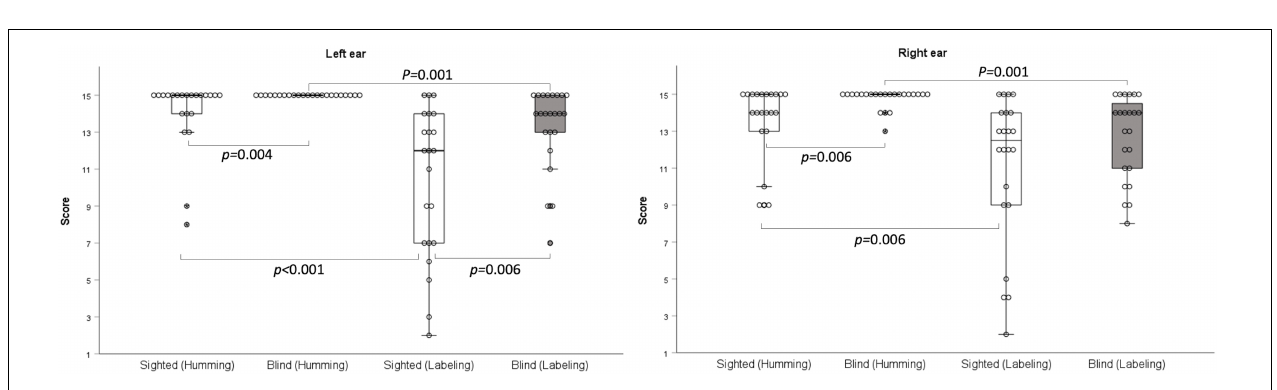
FIGURE 2 | Frequency pattern test. With the humming response, early-blind subjects achieved significantly higher scores than sighted subjects ( right : p = 0.006; left p = 0.004). With the labeling response, the scores were significantly higher in the early-blind subjects in the left ear only ( p = 0.006).